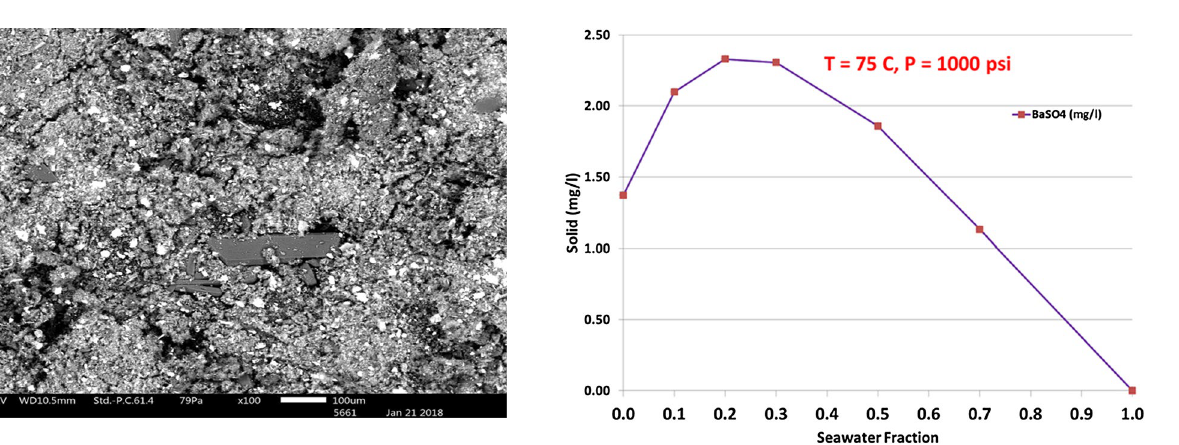
Fig. 5 Barium sulfate mass at different seawater